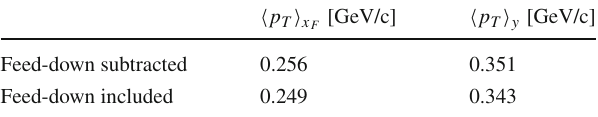
Table 7 (cid:4) p T (cid:5) x for x F = 0 and (cid:4) p T (cid:5) y for y = 0 at F feed-down subtracted and feed-down included